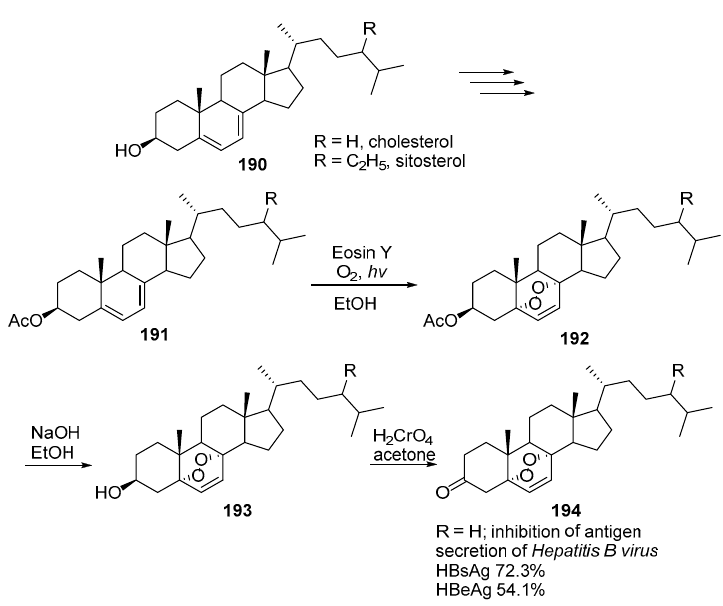
Scheme 31. Synthesis of 194 , antiviral analogs of ergosterol peroxide.